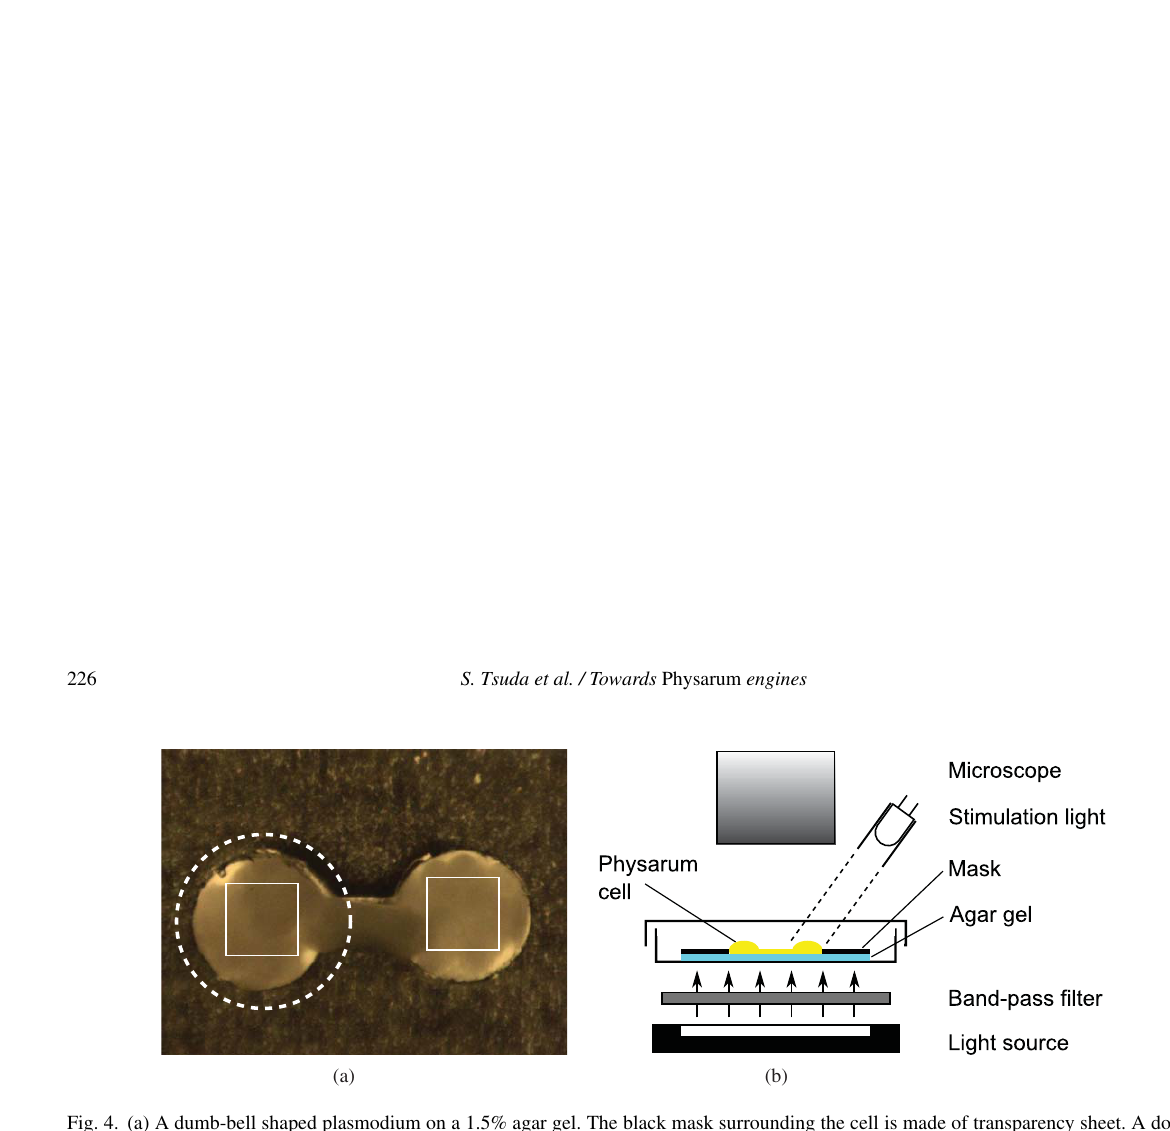
protoplasm from the stimulated well to non-stimulated well.Whenwhitelightisremoved,theoscillationatthe stimulated well came back to the original period and oscillation amplitudes in both wells equalize. Thus, white light does slow down the dumb-bell shaped Physarum plasmodium, and with this light stimulus, the cell can be steered from the outside. We are going to show a stimulated vehicle driven by the Physarum cell can be actually steered by light in the next